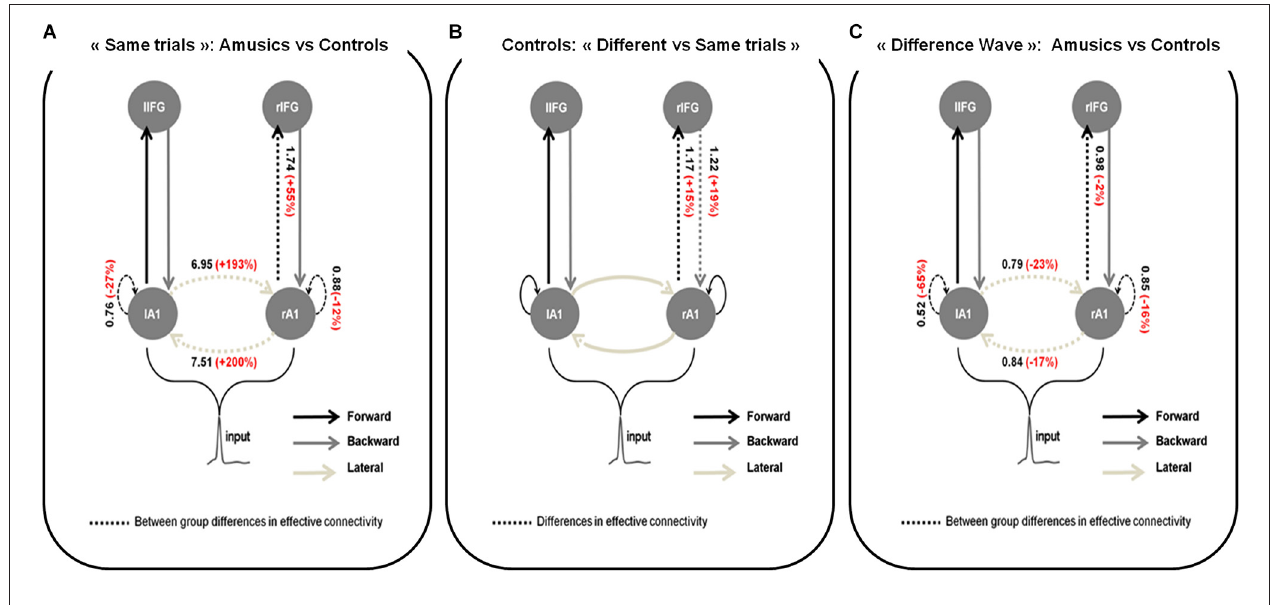
changes in effective coupling are specified (in black: amount of coupling change between groups (A,C) or type of trials (B) ; in red: corresponding relative coupling with amusics coupling expressed in % of control coupling (A,C) or with coupling for “Different” trials expressed in % of coupling for “Same” trials (B)